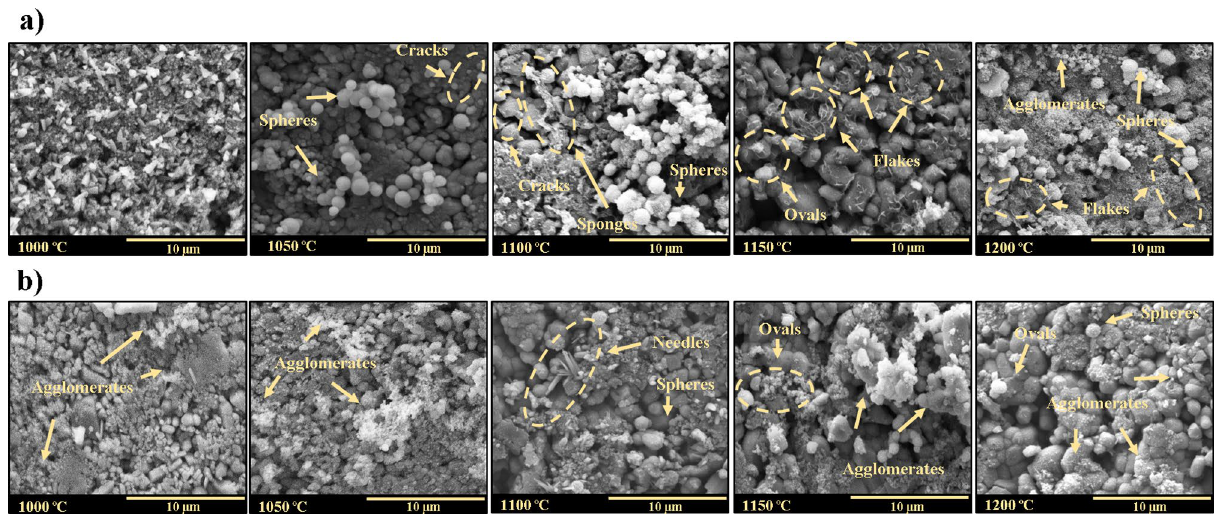
Figure 5. SEM images of the samples treated at different calcination temperatures and after soaking in SBF during ( a ) 3 days and ( b ) 7